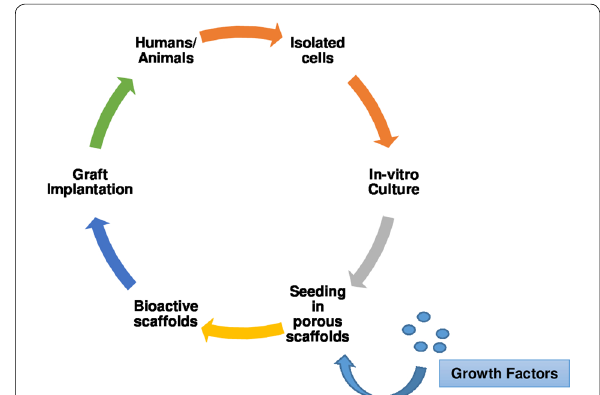
Fig. 8 Tissue engineering process using porous scaffolds